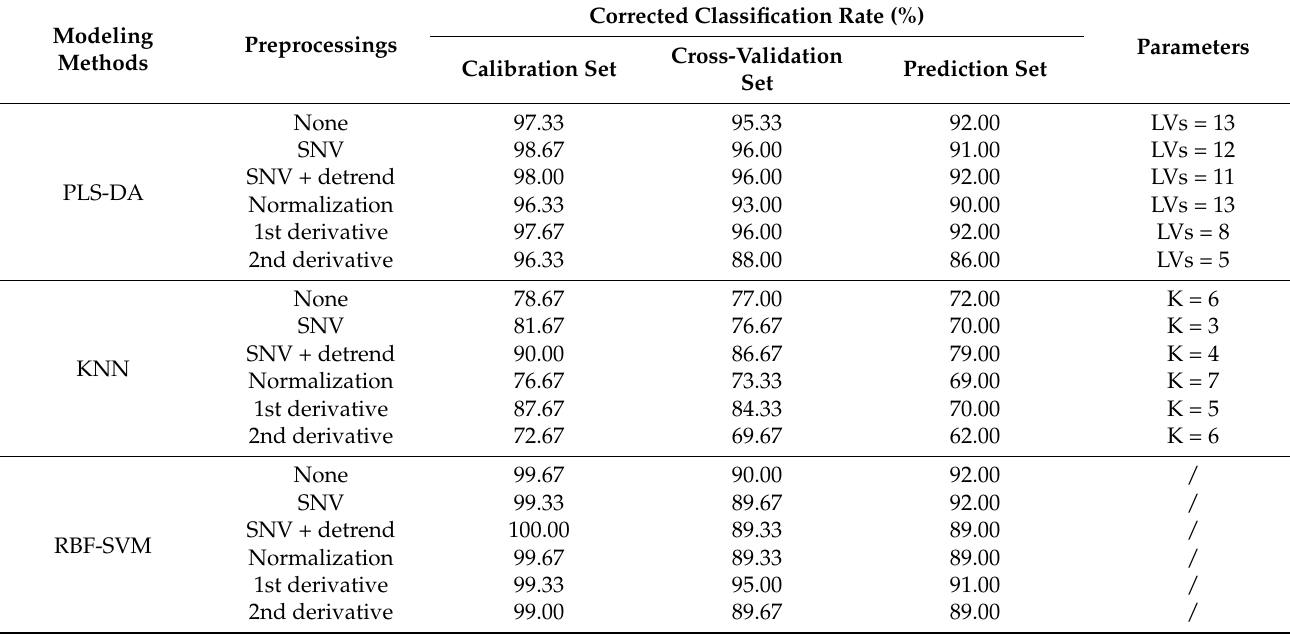
Table 1. Performance of established classification models developed by full spectra with or without preprocessings. Modeling